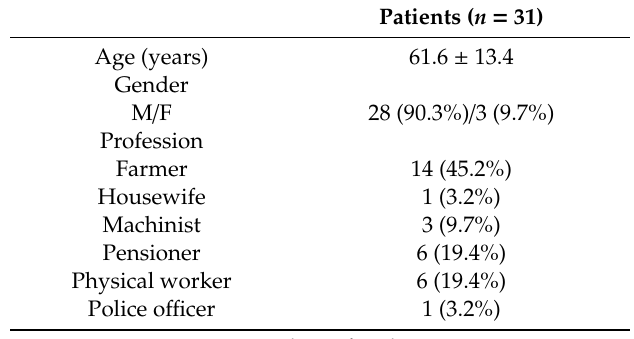
Table 1. The basic characteristics of patients with lower lip cancer.